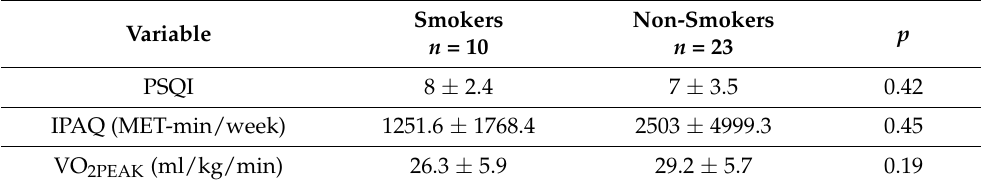
Table 2. Comparison of the main outcome measures between smokers and